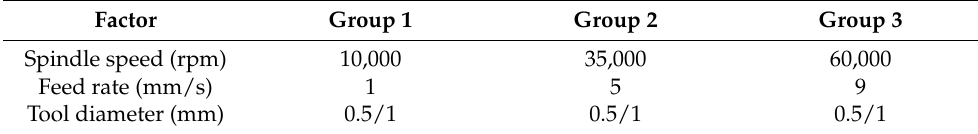
Figure 2. Experimental setup. ( 1 ) infrared camera, ( 2 ) spindle, ( 3 ) milling cutter, ( 4 ) workpiece. Table 2. Micromilling parameters for workpiece machineability analysis.